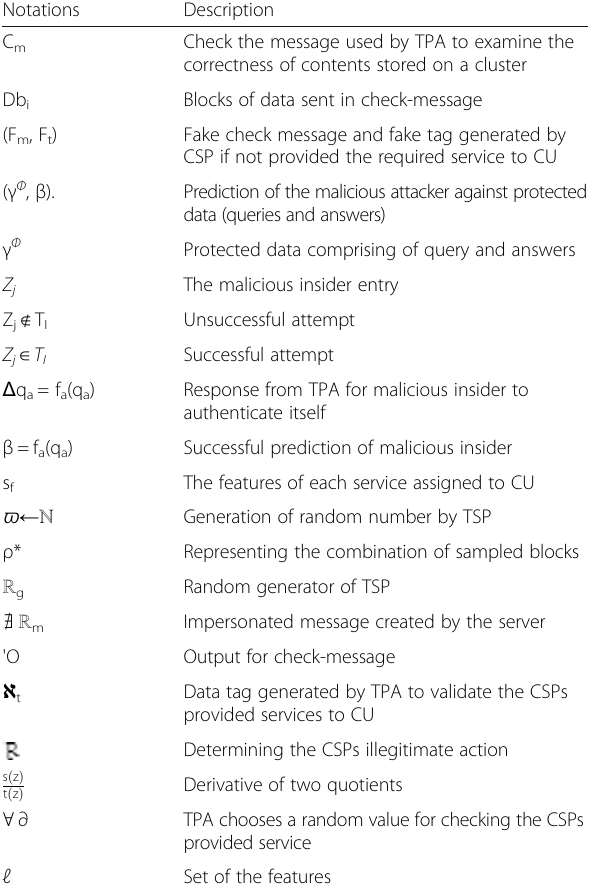
Table 4 System Parameters and Definitions for the authentication process of